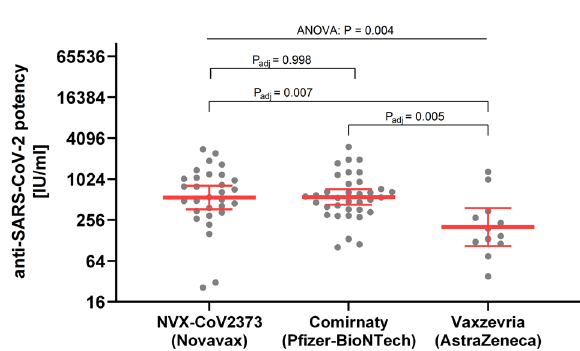
Fig. 1 SARS-CoV-2 neutralizing antibody levels in initially seronegative, twice vaccinated individuals. Serum samples were obtained 15 to 32 days after complete SARS-CoV-2 immunization, i.e., 2 doses of either NVX-CoV2373 ( n = 30), Comirnaty ( n = 35), or Vaxzevria ( n = 12), and analyzed by live virus neutralization assay. Anti-SARS-CoV-2 potency is given as IU/ml, i.e., relative to the fi rst WHO international SARS-CoV-2 antibody standard (NIBSC code 20/ 136). Individual samples are shown as grey dots and overlaid by geometric mean ± 95% con fi dence interval. Statistical analysis (one- way ANOVA with Tukey ’ s multiple comparisons test) was conducted on ln-transformed